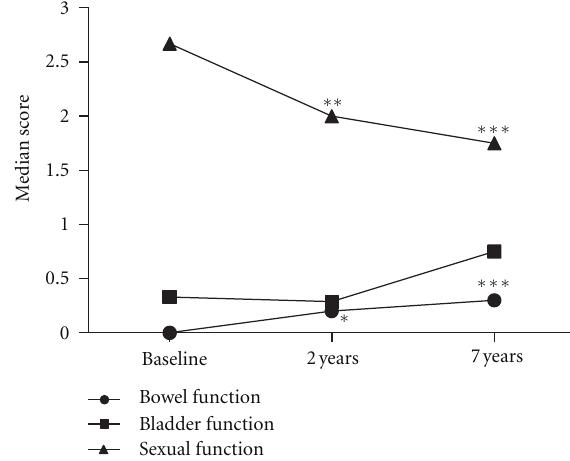
Figure 3: Late e ff ects in normal tissues subjective, objective, management, and analytic scales (LENT/SOMA) questionnaires data. Line graph showing median scores at baseline, 2-year and 7-year followup (bowel function, ∗ baseline to 2 years P = 0 . 015, ∗∗∗ baseline to 7 years, P < 0 . 001; sexual function, ∗∗ baseline to 2 years P < 0 . 01; ∗∗ 2 years to 7 years P < 0 . 01 (not shown), ∗∗∗ baseline to 7 years P < 0 .